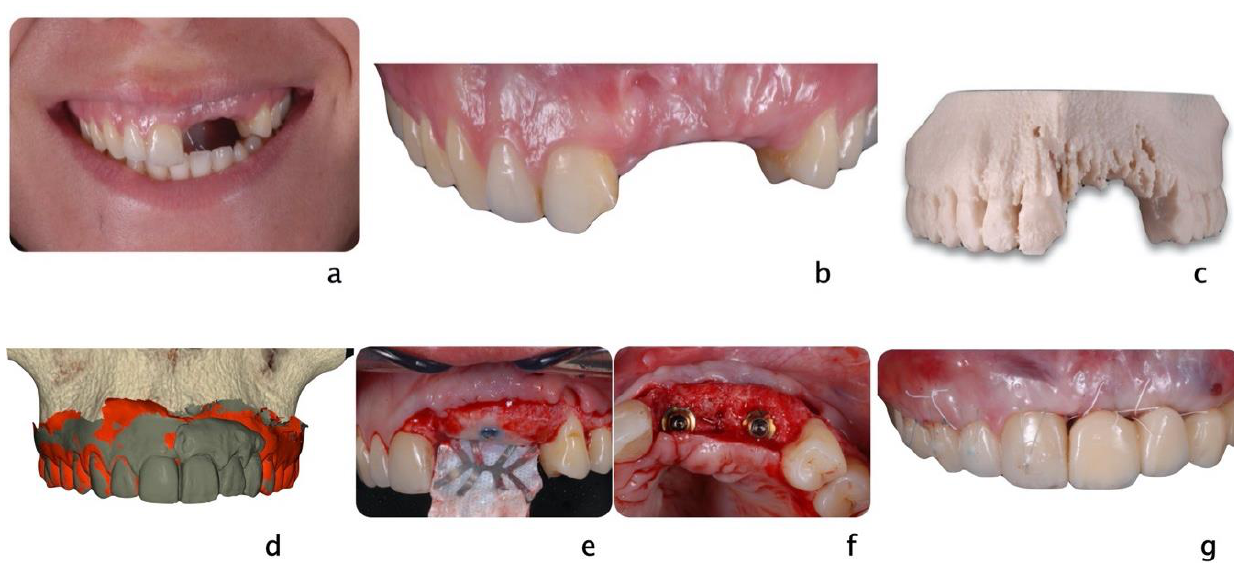
Figure 4. A 24-year-old female fell from her bike during a race. She hit the tarmac and resulted in losing teeth#9, 10 and 11 ( a , b ) as well as a portion of the alveolar bone ( c ) as seen on the 3D print of the maxilla. An incisal chip on tooth #8 completed the damage of the fall. After an analysis of residual hard and soft tissue volumes, a digital wax-up was created to plan the future implant placement and restorations ( d ). Guided tissue regeneration was performed, and implants were placed in a Type 4 timeline ( e , f ). A provisional fixed partial denture and connective tissue graft were inserted to improve esthetics and tissue conditioning ( g ).